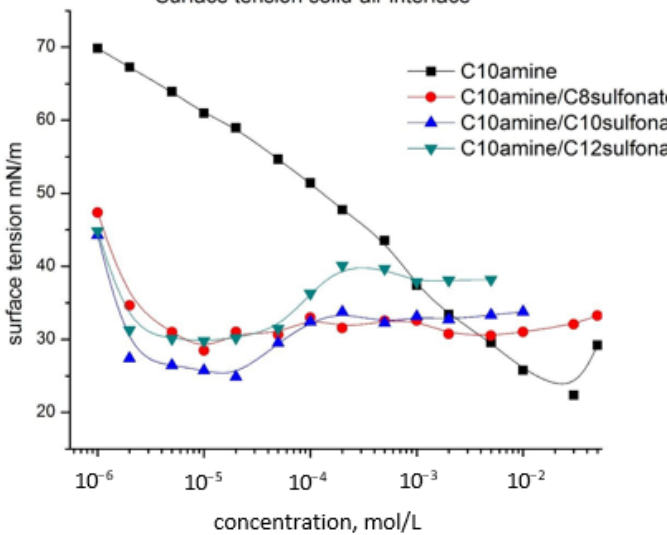
Figure 4. Calculated surface tension vs. concentration for different systems of solid–air surface.